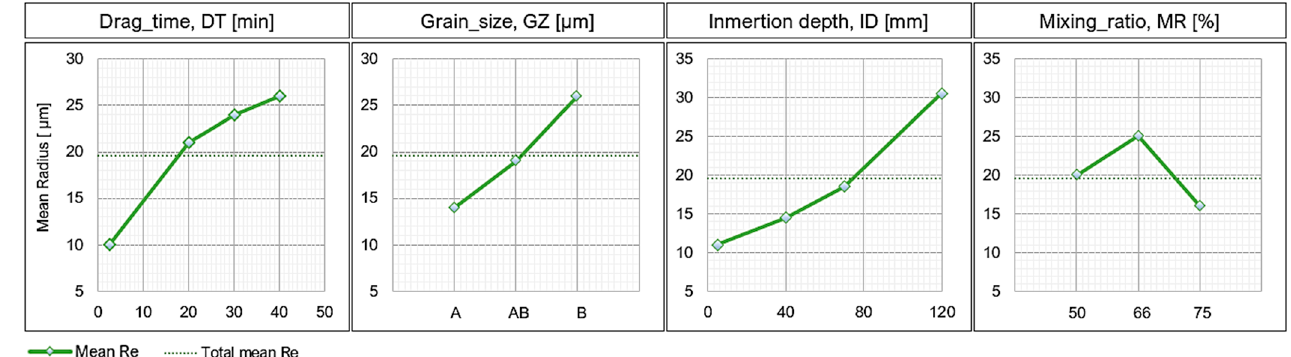
Figure 7. Effect of experimental parameters on cutting edge radius.